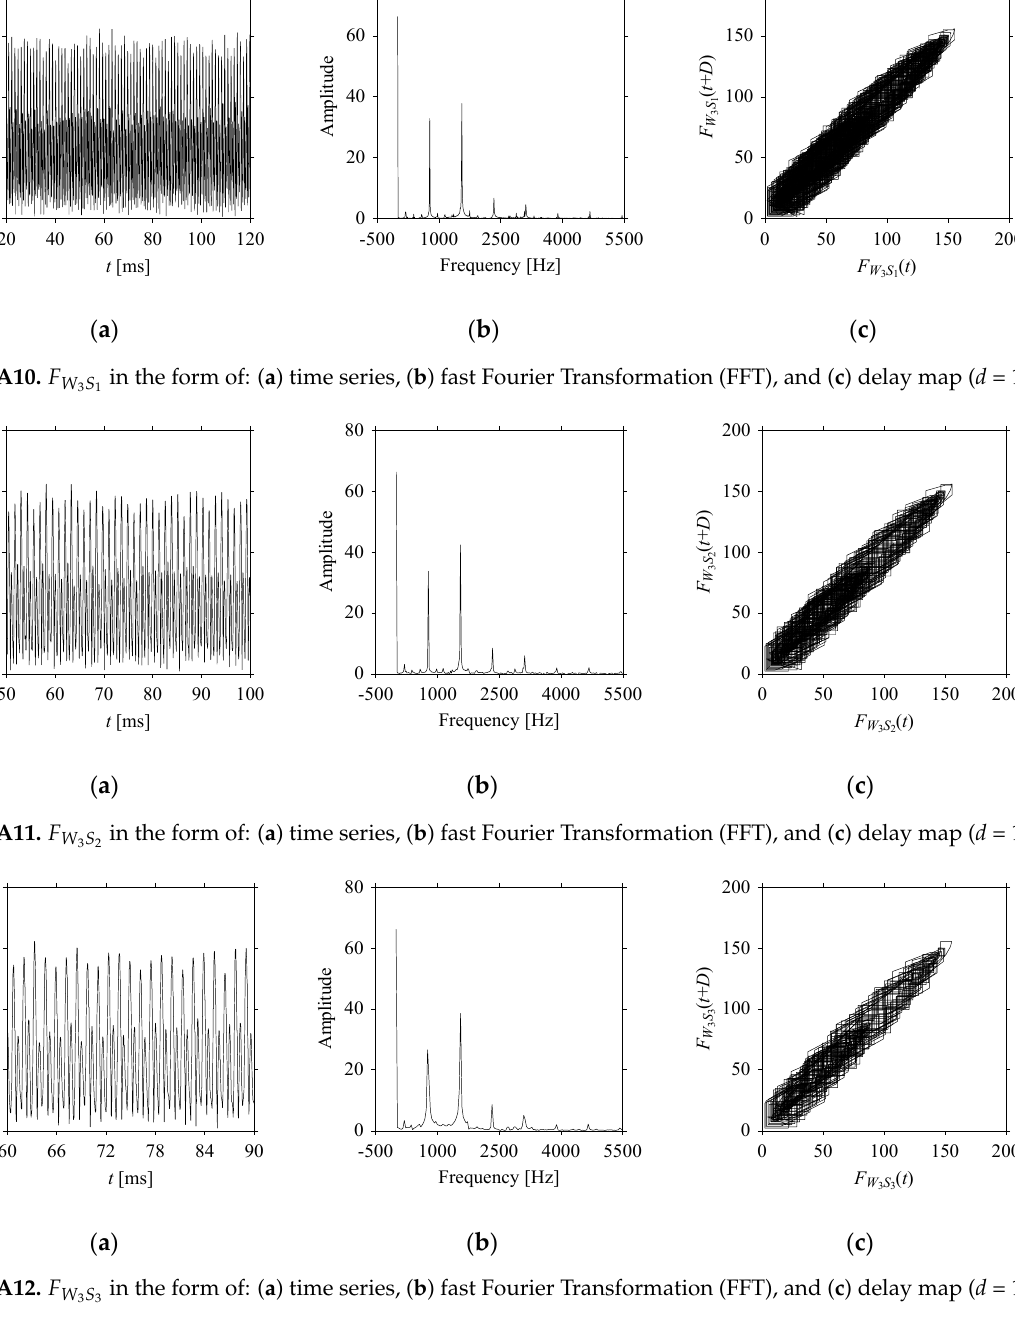
Figure A9. F W in the form of: ( a ) time series, ( b ) fast Fourier Transformation (FFT), and ( c ) delay map ( d = 1). 3